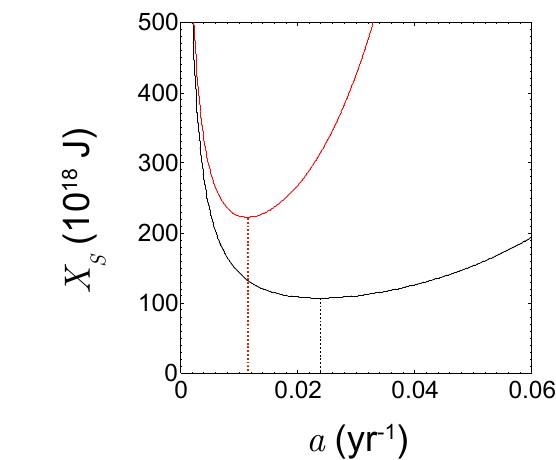
Figure 6. The relationship between the relative growth rate on global primary energy, a , and the total energy not directly used in growth, X S . Two scenarios are presented, one with an integration timescale of T = 42 years (–) and one with an integration timescale of T = 84 years